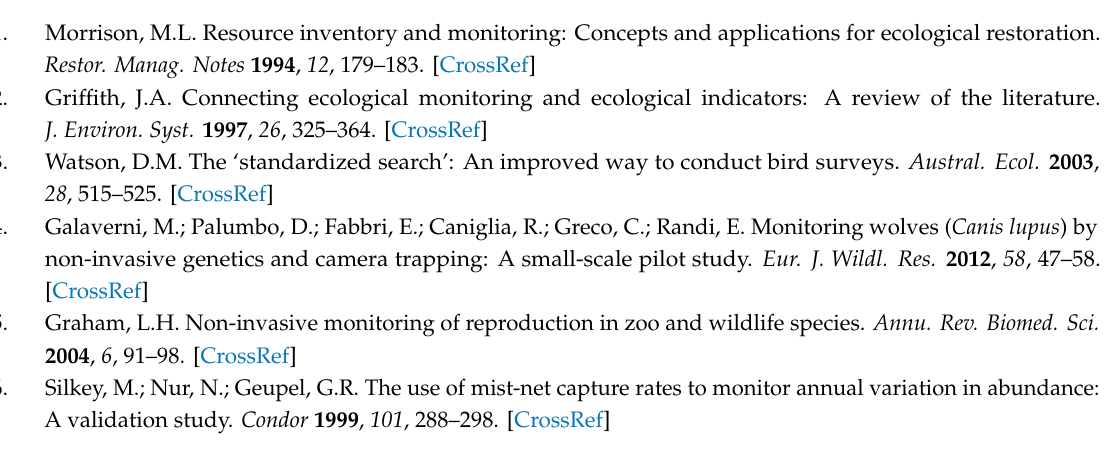
Table S1: Article information for wild animal monitoring with RPAS which had been searched on Web of Science (n = 157) and selected articles (n = 121) with detailed information on study species, sites, and